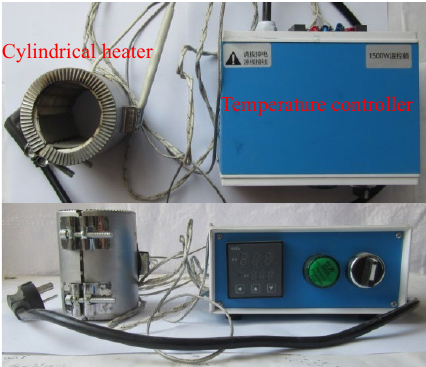
Figure 1. Segmented heating device for coal sample.